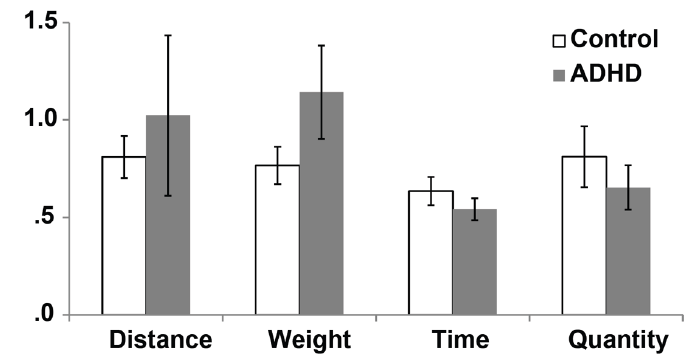
Figure 4. Mean absolute distance from the norms for the Hebrew-version of the Biber cognitive estimation task as a function of group (ADHD and Control) and estimation